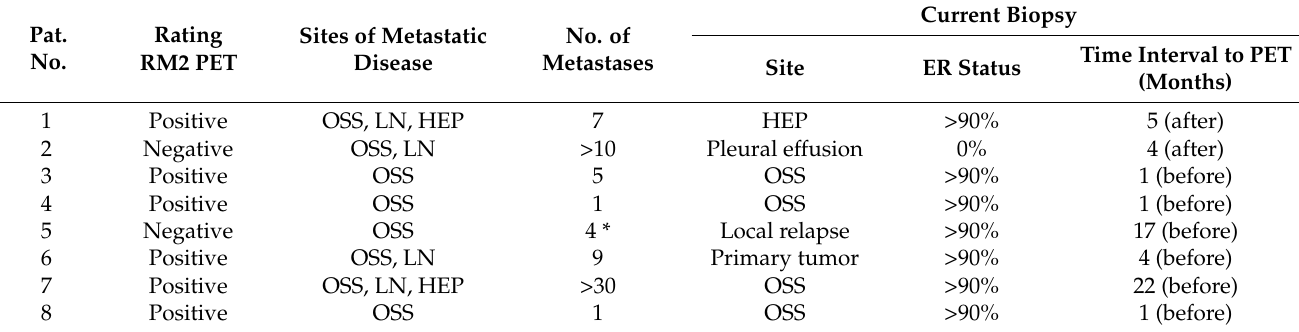
Table 2. Findings on [ 68 Ga]RM2 PET/CT compared to current